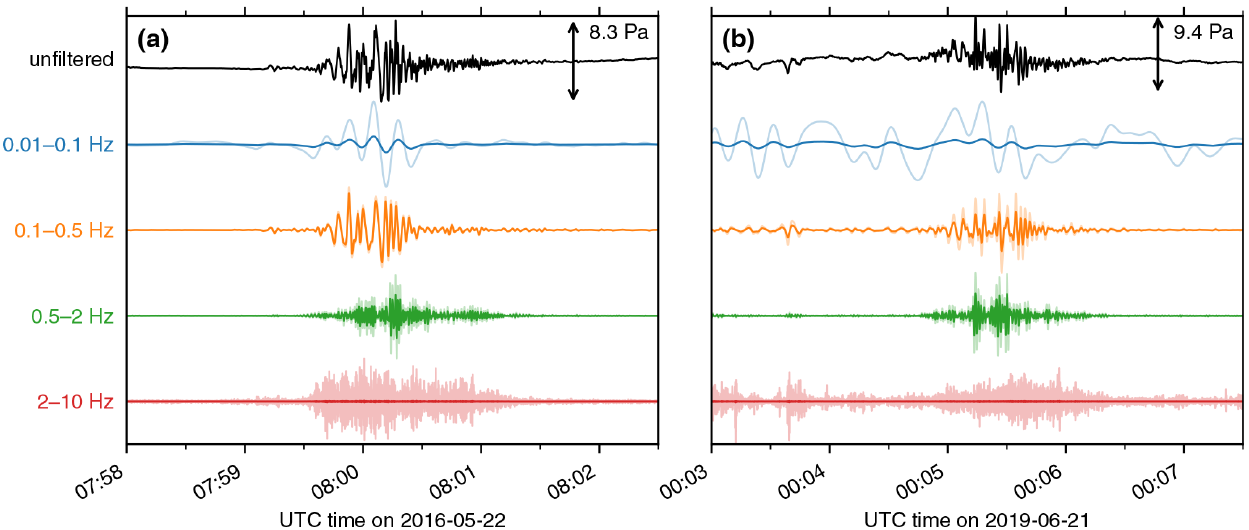
Figure 7. Infrasound signals in different frequency bands for the (a) 2016 and (b) 2019 avalanches. Signals were recorded on Transportable Array station O20K, the closest infrasound sensor to Iliamna Volcano at the time. Signals plotted as solid lines are normalized relative to the black unfiltered trace. Translucent lines are individually normalized